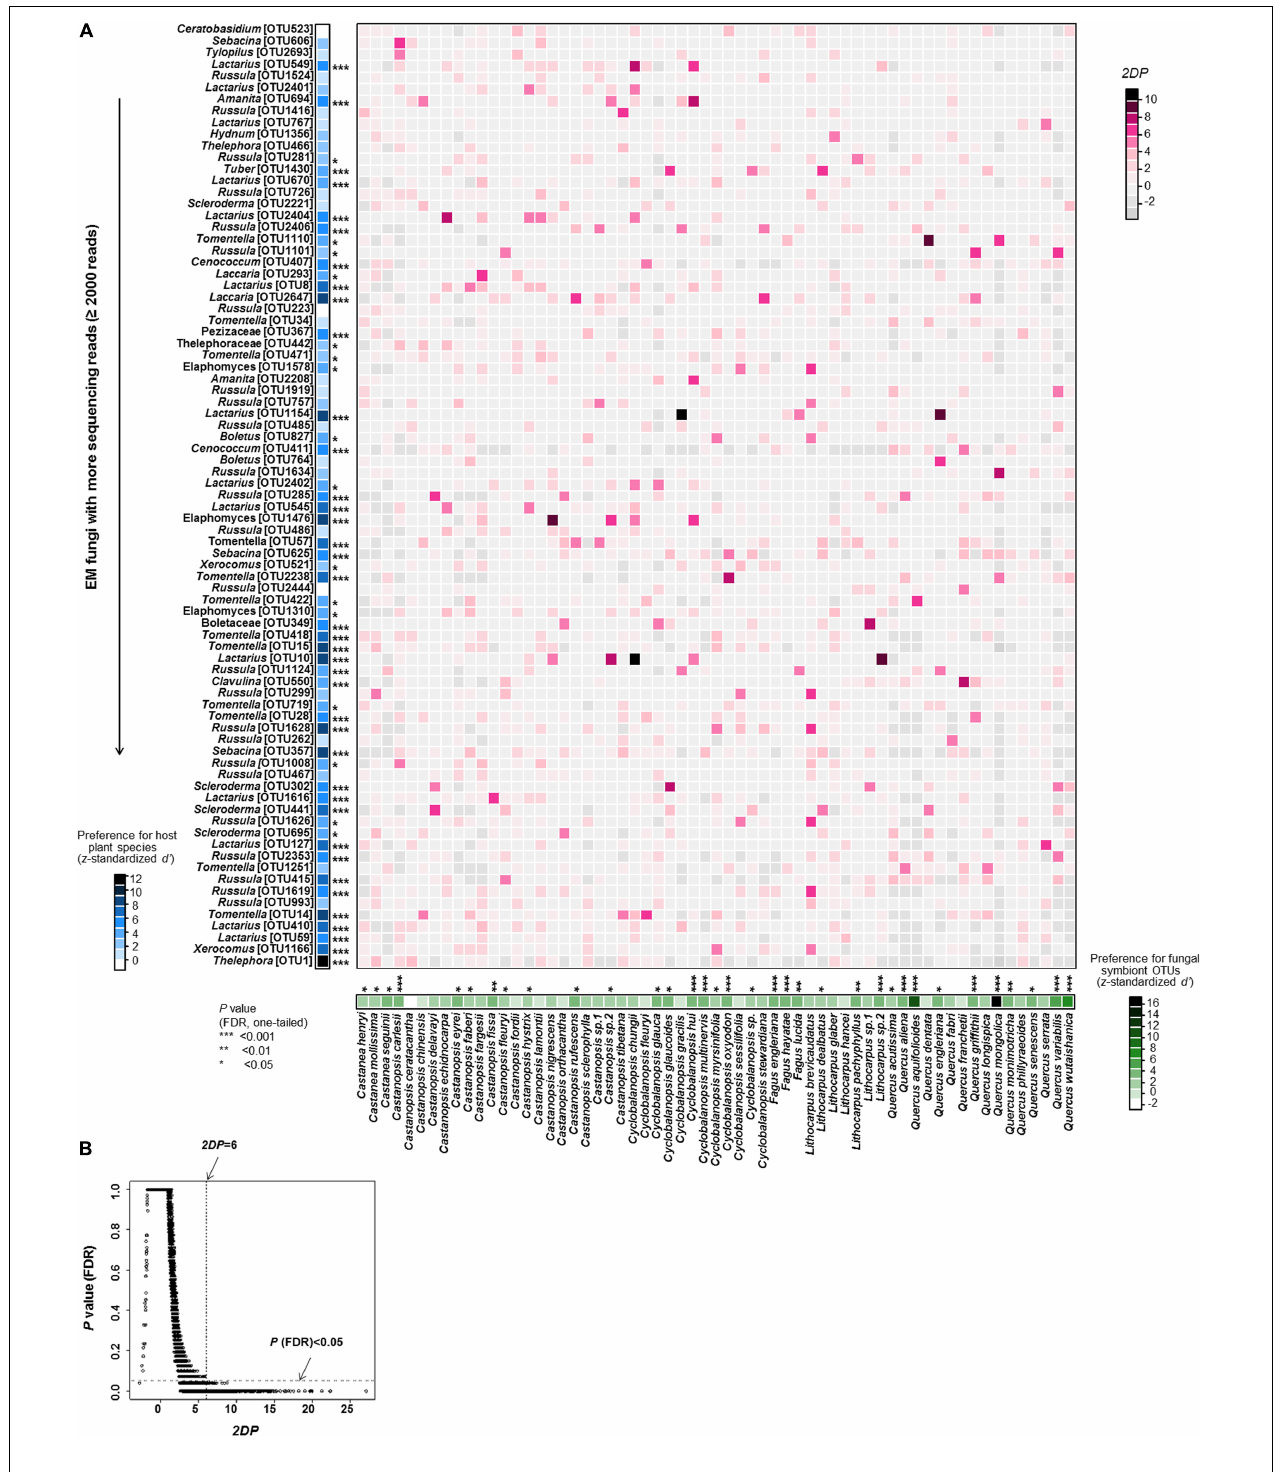
FIGURE 4 | Preferences observed in Fagaceae plant-ectomycorrhizal (EM) fungus associations. (A) Preference scores. The standardized d ’ estimate of preferences for EM fungal operational taxonomic units (OTUs) is shown for each plant species (column). Likewise, the standardized d ’ estimate of preferences for plant species is indicated for each of the commonly observed fungal OTUs (row). Each cell in the matrix indicates a two-dimensional preference ( 2DP ) estimate, which measures to what extent the association of a focal plant-fungus pair was observed more/less frequently than would be expected by chance. The P -values are shown as false discovery rates (FDRs) in the plant/fungus analysis. (B) Relationship between 2DP and FDR-adjusted P -values. 2DP values greater than 6 represent strong preferences (FDR < 0.05).